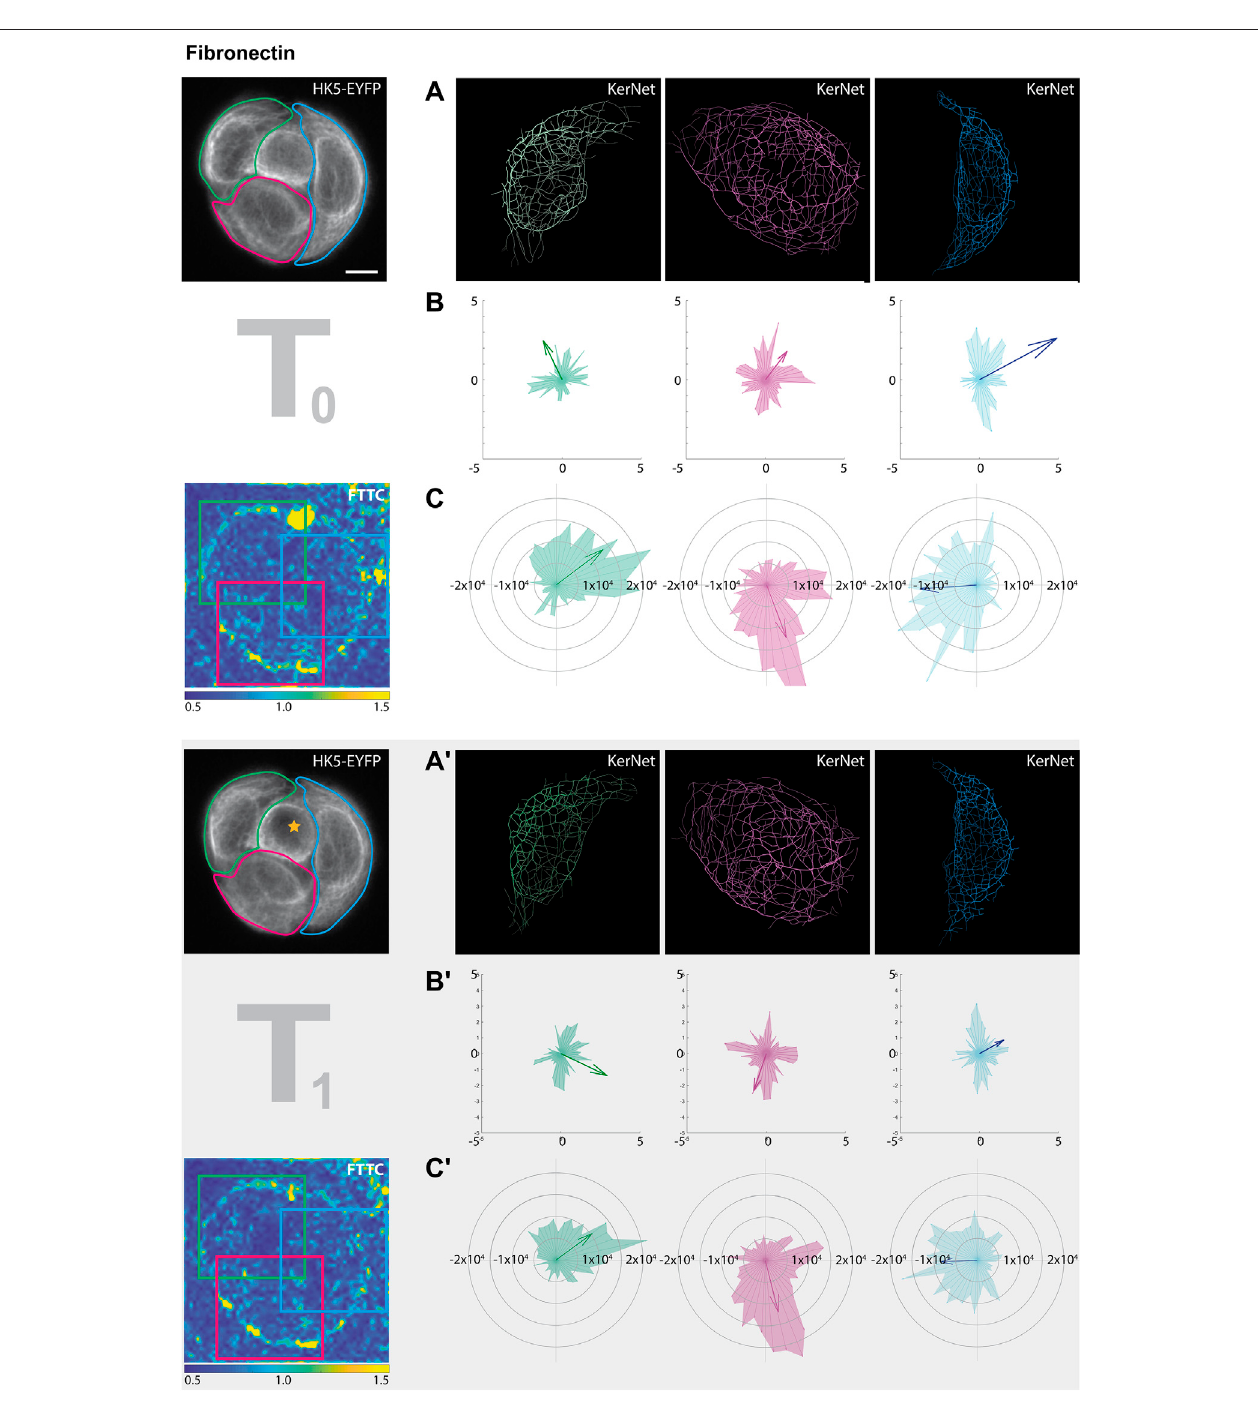
FIGURE6| Photoablation affects KFsegmentorientationand traction forces differently.Thedatasets forthis fi gurecorrespondtothoseshownintheleftcolumns of Figure 5 (partially shown again at left). In this instance, however, the cellular ablation response of segmented fi laments was analyzed in single cells within the HaCaT B10 cell group growing on fi bronectin. The different cells are color coded in green, red and blue (from left to right). (A, A ’ ) Show the digitally segmented 3D networks before and after photo-oxidation. (B,B ’ ) Depict the corresponding radial histograms of KF segment orientation and sum vectors in relation to the center of the micropattern. (C,C ’ ) Present the corresponding traction force vectors in the areas delineated by colored squares in the FTTC image. They are represented by radial histograms and the resulting sum vectors are illustrated by arrows. Scale bar: 10 μ m.